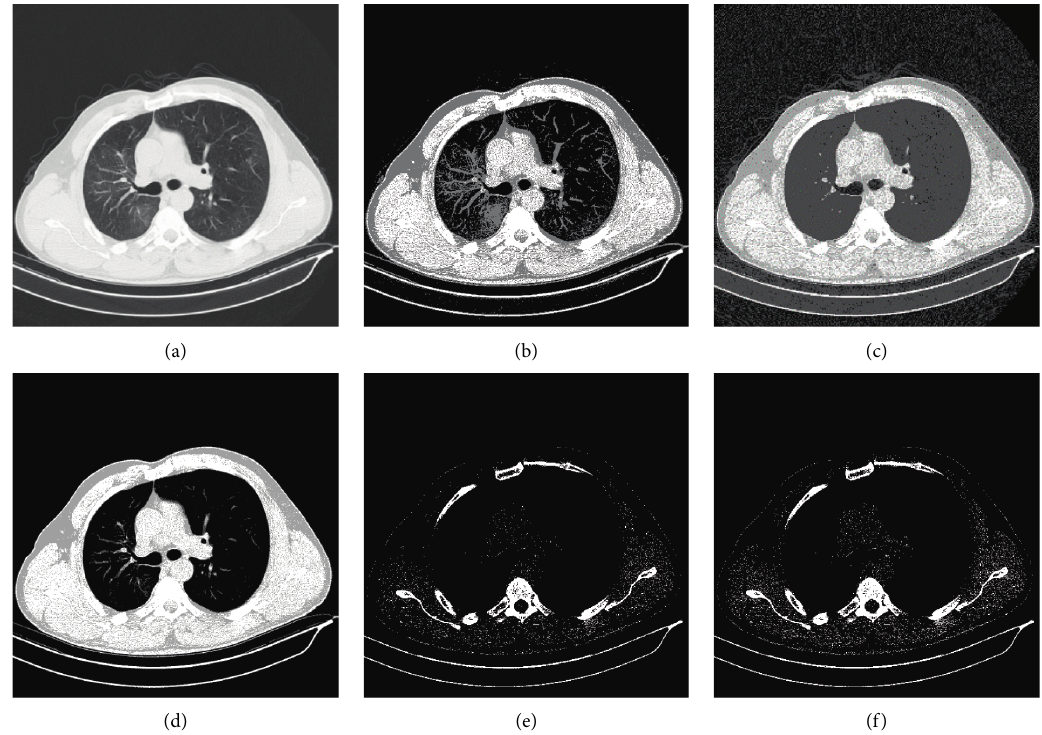
Figure 10: The comparison outcomes. (a) Original CTimage-3; (b–d) segmentation result of threshold levels 2,3, and 4, respectively, of the proposed approach; (e) segmentation results obtained by Tao [21]; (f) segmentation results obtained by Tang [22].